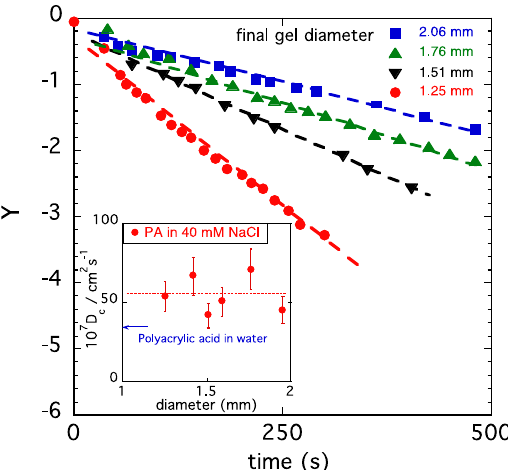
Figure 6. Variation in Y in Equation (10) as a function of the swelling time for PA gels swollen in 40 mM NaCl solution. Dashed curves are least squares fits to Equation (10). Inset: collective diffusion coefficient D c of different hydrogels.